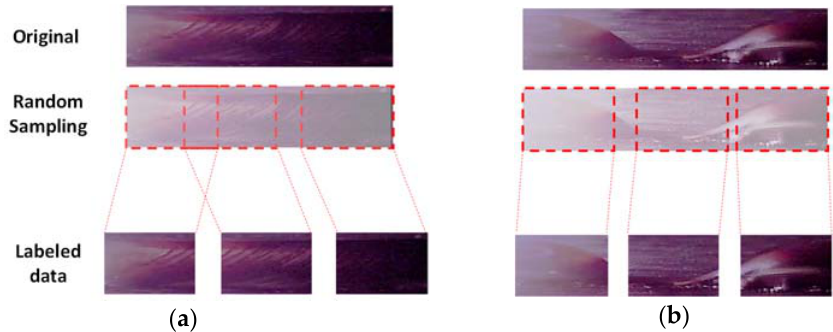
Figure 6. ( a ) Normal bead shape and labeled data; ( b ) abnormal bead shape and labeled data.